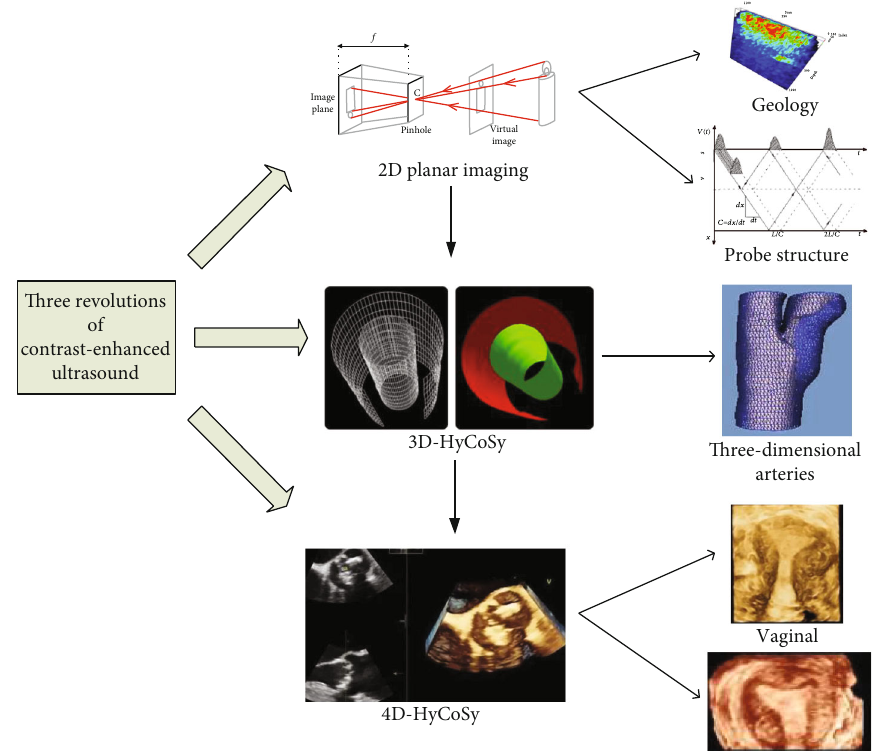
Figure 1: Revolutionary history of contrast-enhanced ultrasound technology.